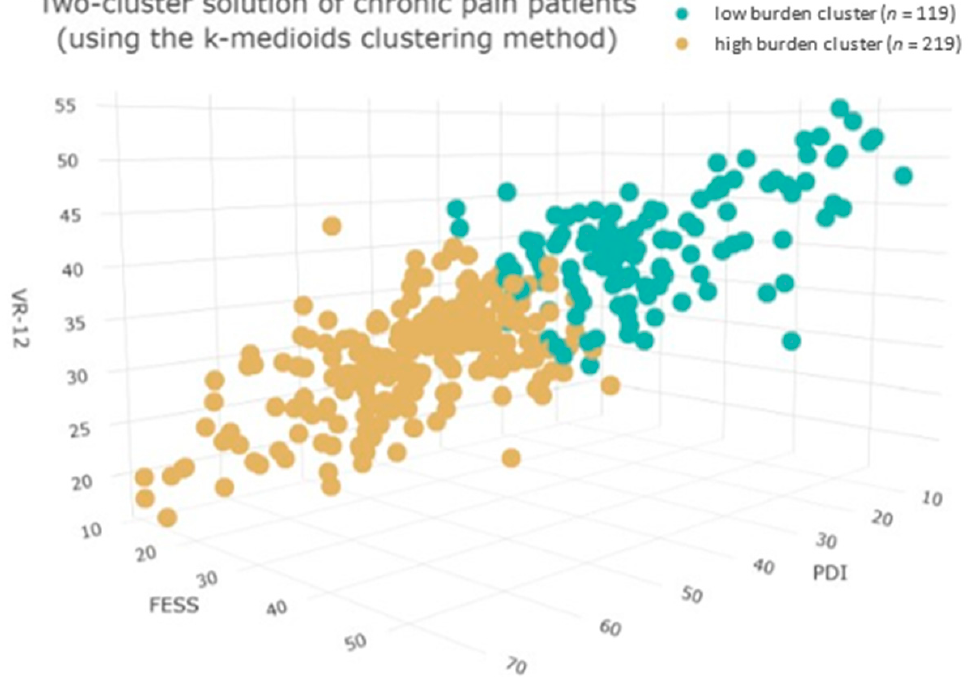
Figure 3. n = 338. Shown above is a two-cluster analysis of the k -medoids method using the three scales: PDI (perceived pain disability), FESS (pain-specific self-efficacy), and VR-12 (health-related quality of life), in a sample of patients with chronic pain. For the sake of simplicity, the two VR-12 subgroups MCS (mental component score) and PCS (physical component score) were summarized in a VR-12 total mean